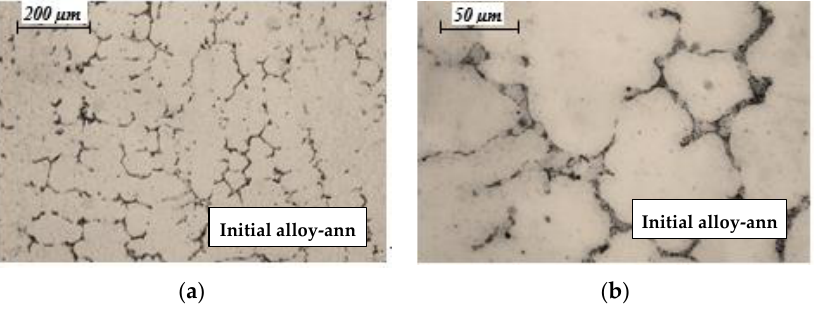
Figure 2. Optical microphotographs of initial CoCrMo alloy after heat treatment: ( a ) 100 × magnifica- tion; ( b ) 400 ×